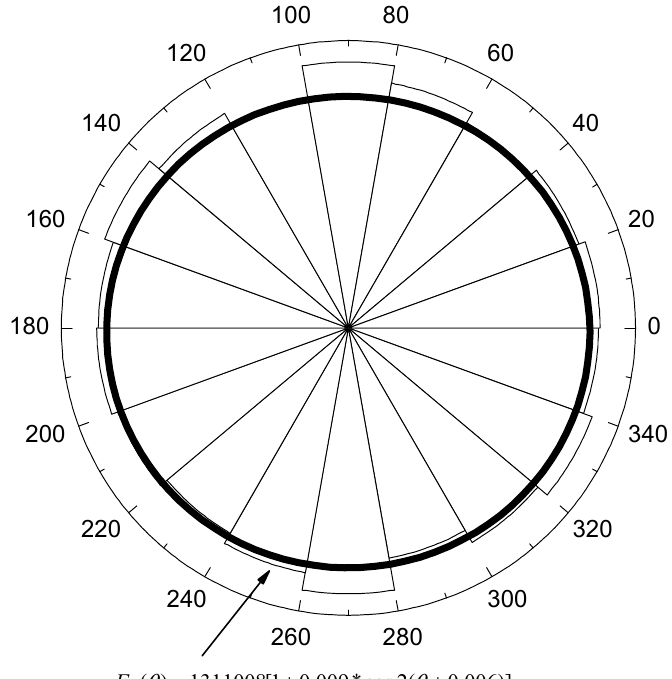
Figure 7. Normal contact force distribution at the isotropic state.